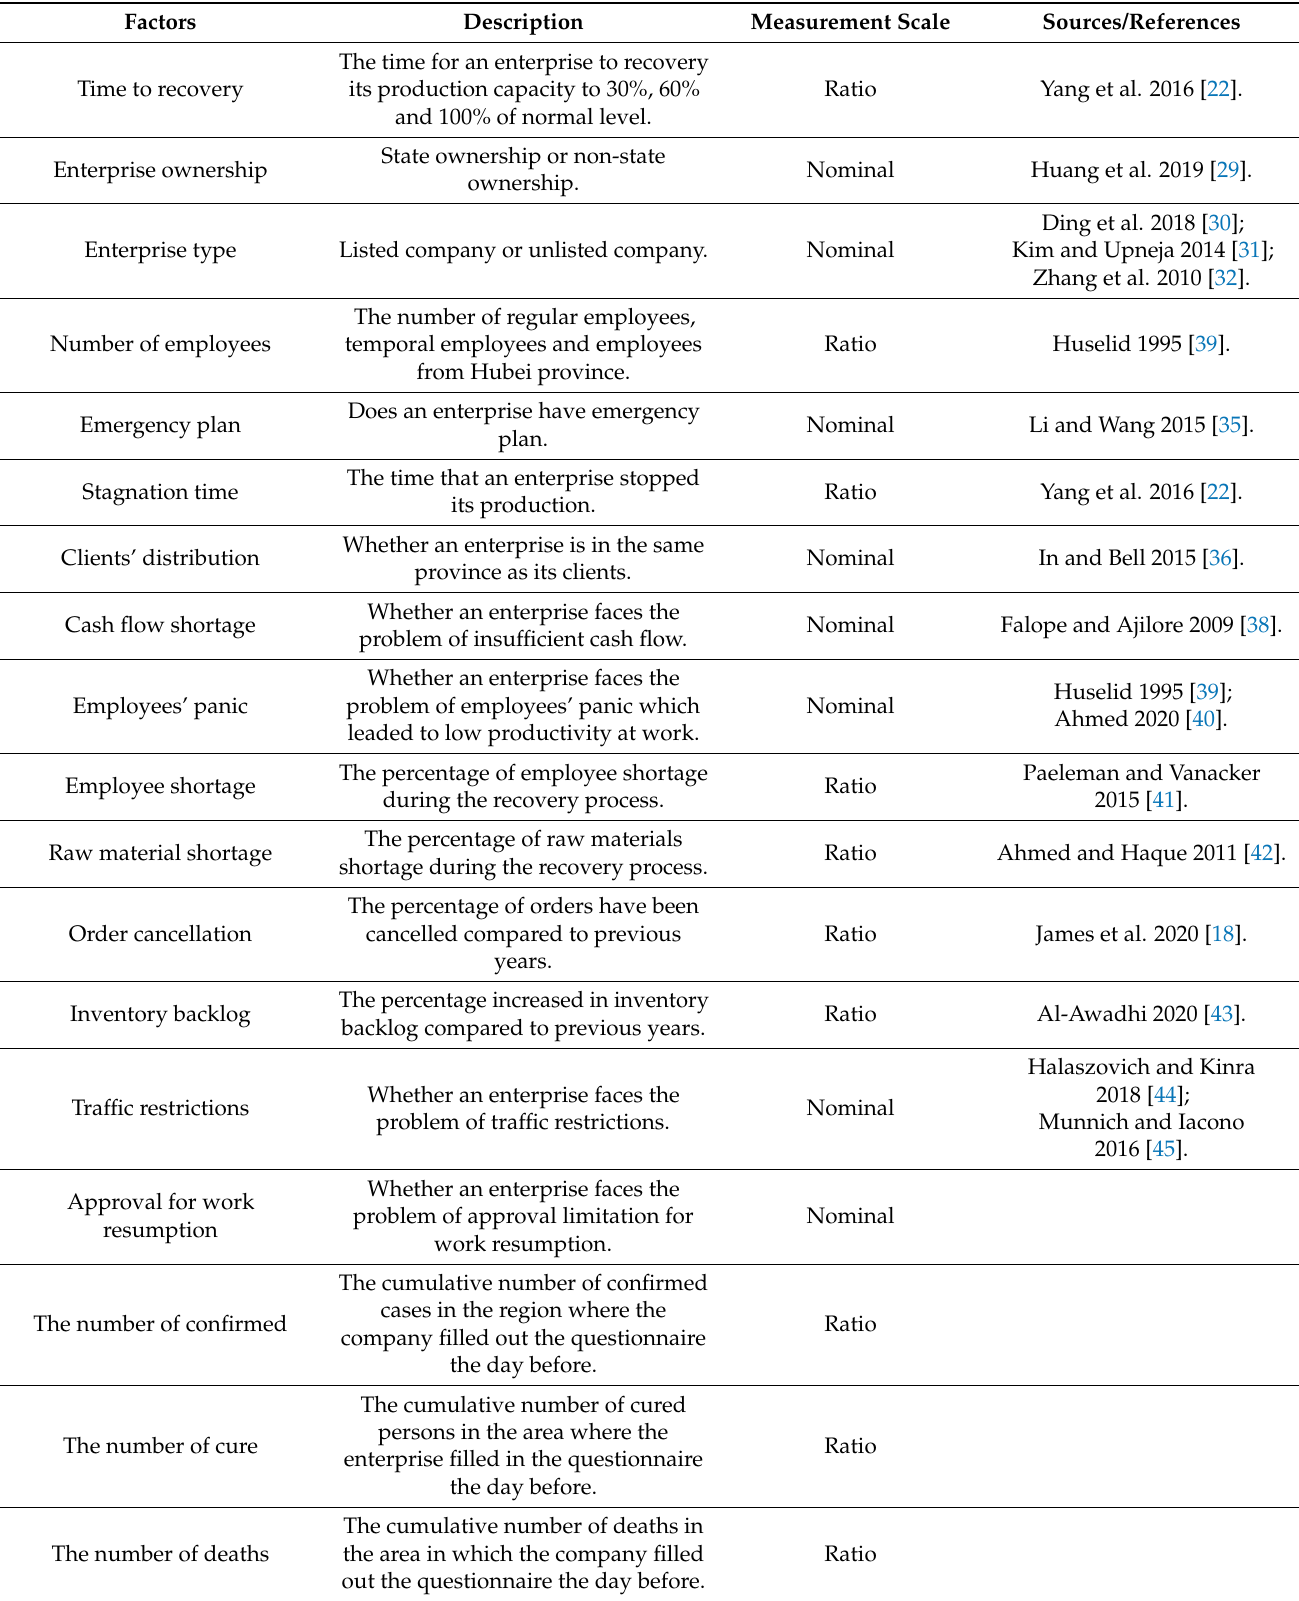
Table 1. The investigated factors in the